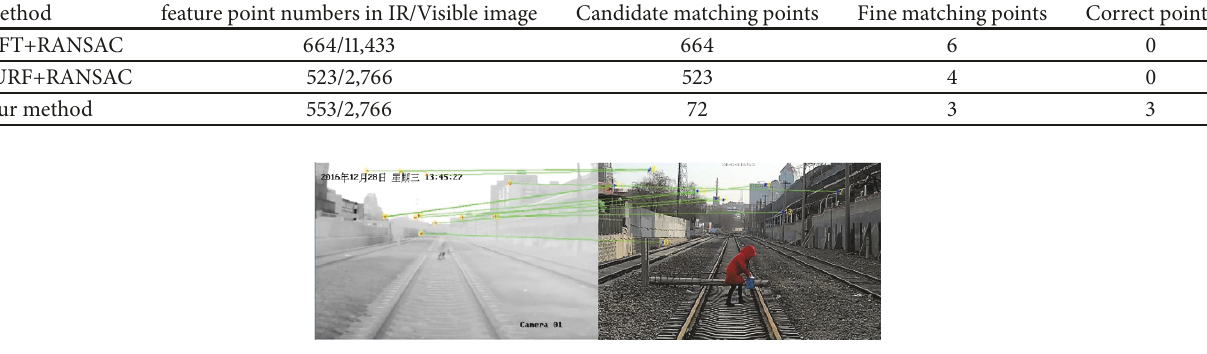
Figure 5: Refining result of geometric constraint.